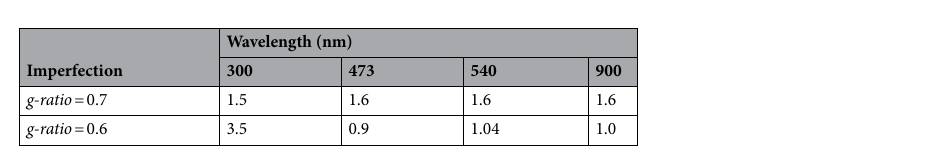
Table 3. Orders of magnitude the transmission for typical wavelengths in g-ratio = 0.7 and g-ratio = 0.6 compared to a g-ratio = 0.78 when light launched to Axon in Fig. 9 (a).